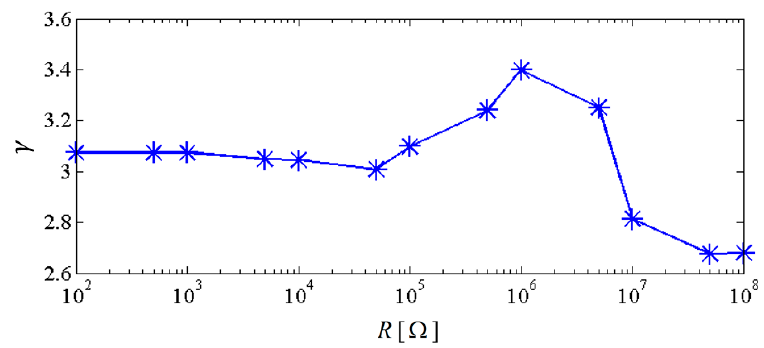
Figure 12. Output power area ratio of the NPEHS-2 versus load resistance.